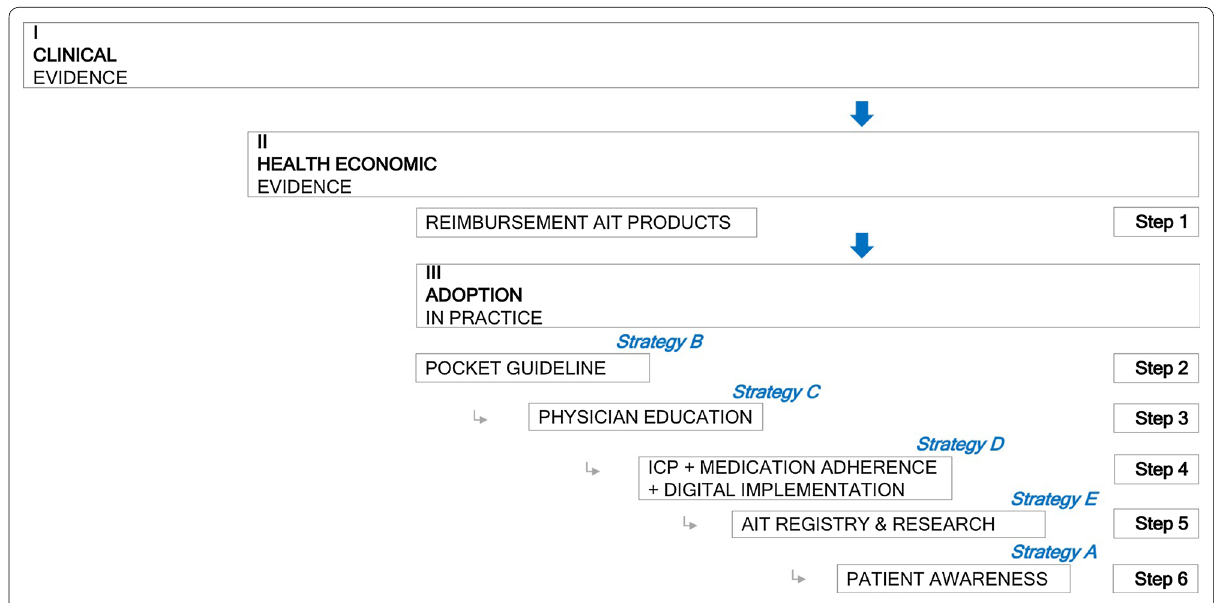
Fig. 3 ARIA‑EUFOREA implementation strategy for AIT adoption. ICP: integrated care